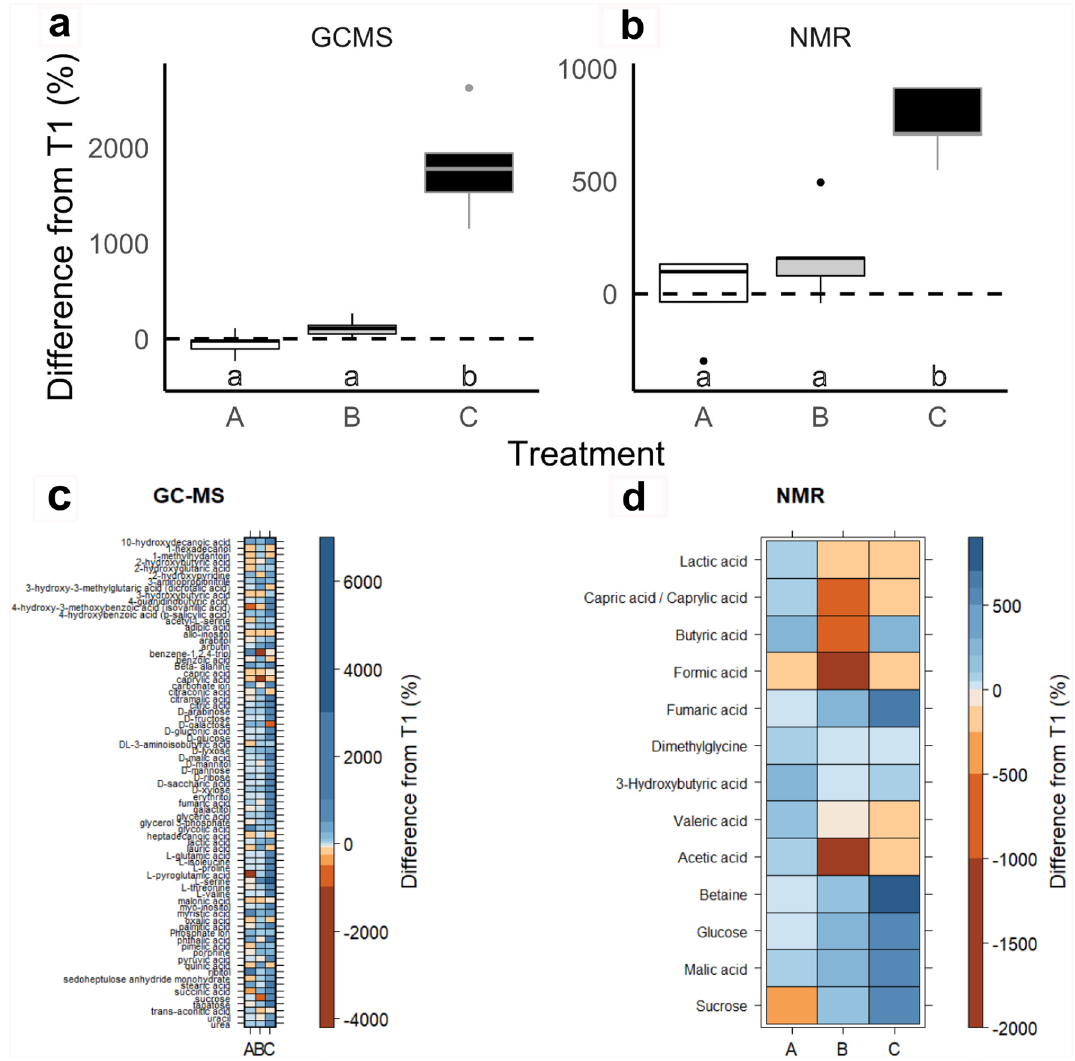
Figure 2. Drought severity treatments (A = conrol, B = mild, C = severe) affected normalized peak area of GC– MS and NMR concurrently. The percent difference between before (T1) and after treatment (T2) of normalized peak area of GC–MS ( a ) and NMR ( b ). Lowercase letters indicate significant differences in means among treatments at T2 ( p < 0.05, Supplementary Tables S3, S4). Note the different y-axis scales. Heat maps describing the percent difference between T1 and T2 of z-scores of identified metabolites for each treatment identified with GC–MS ( c ) and NMR ( d ). List of GC–MS compounds in panel C in Supplementary Table S5. 64 of 206 GC–MS detected metabolites (32 of the 64 were identified) increased from A to B to C and 28 of 206 GC–MS detected metabolites (8 of the 28 were identified) decreased from A to B to C. 5 of 13 NMR detected metabolites increased from A to B to C and 3 of 13 NMR detected metabolites decreased from A to B to C (3 identified) at T2 (Fig. 5). The 10 shared compounds contained 6 identified compounds: urea, D-saccharic acid, erythritol, L-glutamic acid, L-isoleucine, and pyruvic acid (Fig. 5). The 7 compounds unique to treatment C contained 3 identified compounds: arubtin, D-gluconic acid, and L-proline (Fig. 5; see also Supplementary Fig. S9 for a Venn diagram of all compounds (identified and unidentified) at T2 including compounds present at both T2 and T1). In contrast to GC–MS, NMR metabolites unique to each treatment were not observed. Van Krevelen diagrams of FTICR-detected compounds showed that the composition of high-level chemical classes shifted between T1 and T2 and among treatments A, B, and C (Fig. 6). Many of the root exudate compounds and compound classes associated with increasing drought severity may alter plant drought responses and the rhizosphere microbiome (Table 2). These root exudate compounds most strongly associated with the separation of treatments at T2 as detected with GC–MS (Fig. 3, Supplementary Figs. S4, S5) and NMR (Supplementary Figs. S6, S7), and included CHOS, unsaturated hydrocarbons, and tannins (Fig. 4). Compounds unique to treatment C (Fig. 5) serve various functions in altering plant drought responses and the rhizosphere microbiome (Table 2, see Discussion).